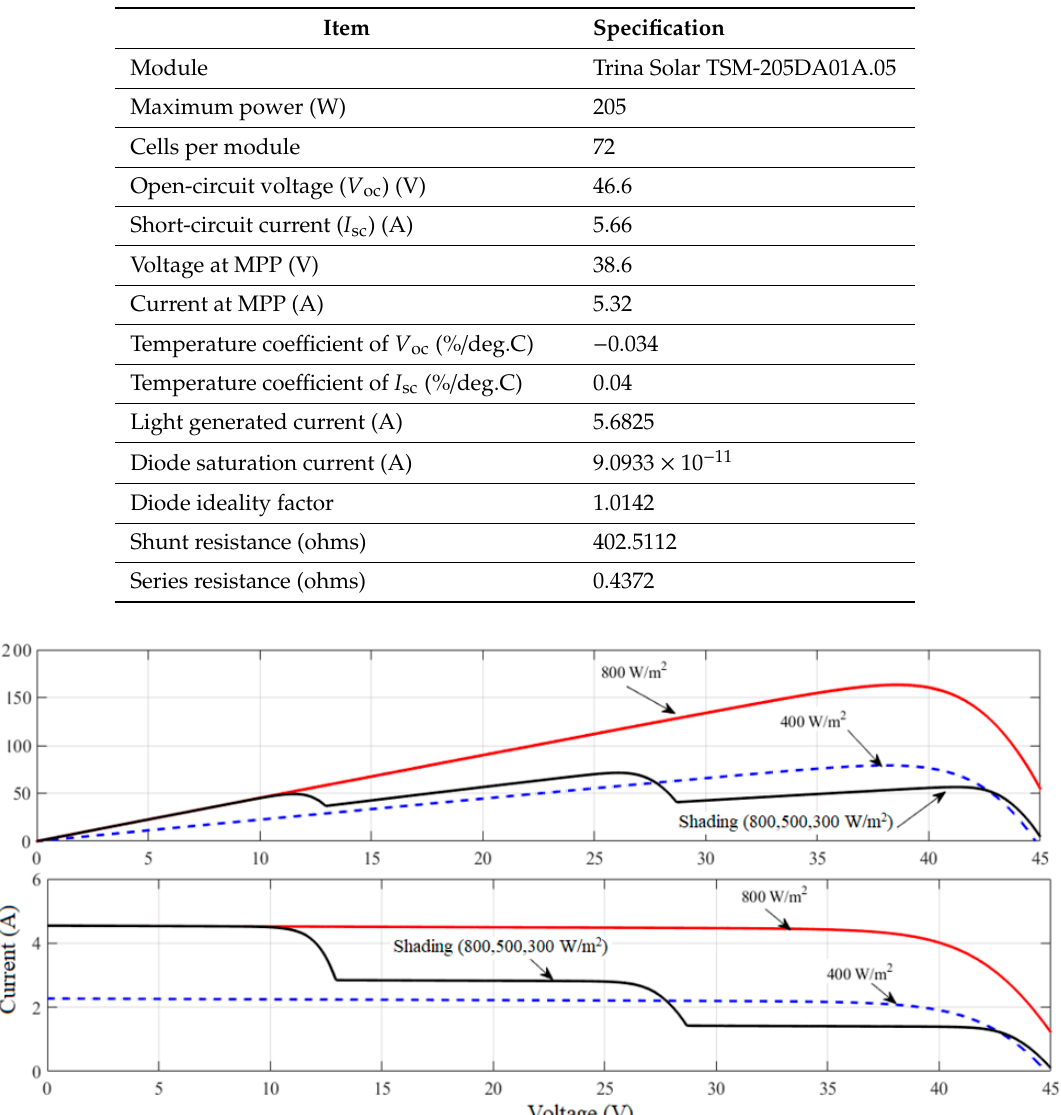
Table 2. The electrical specifications of Trina solar panel.